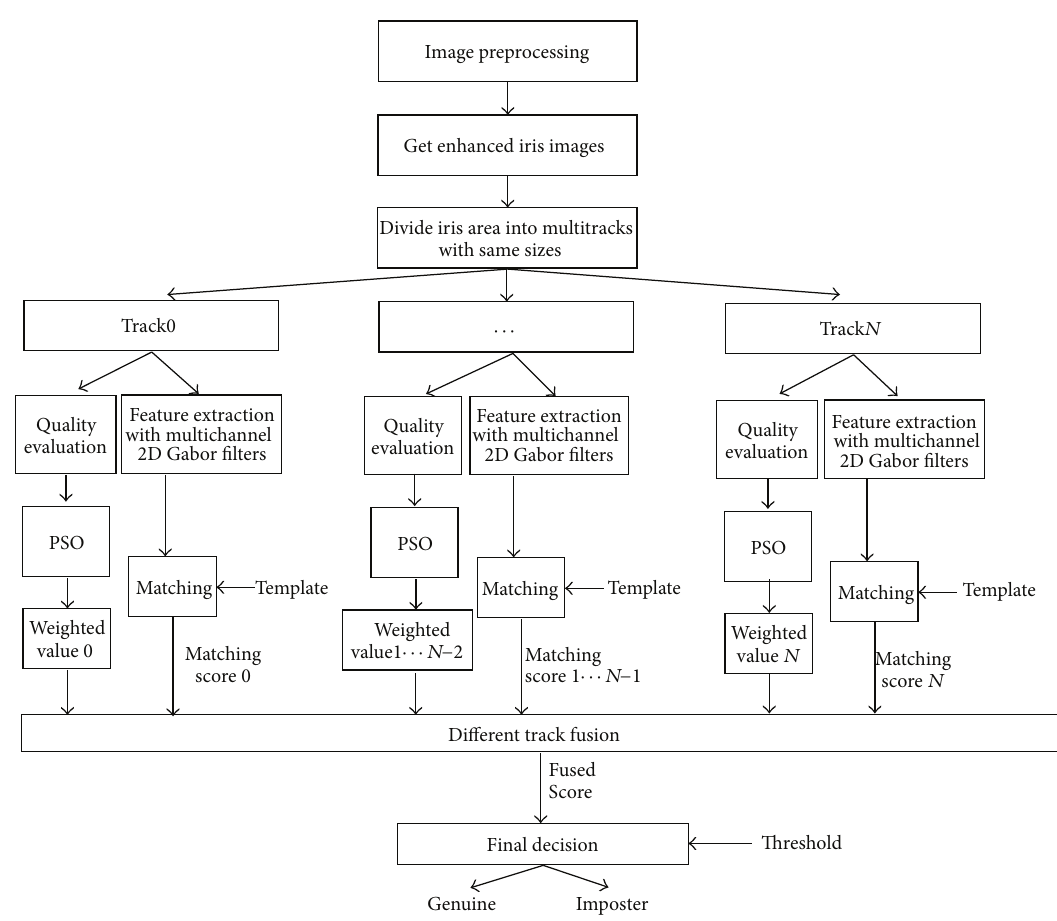
Figure 7: Architecture of the proposed fusion recognition system.